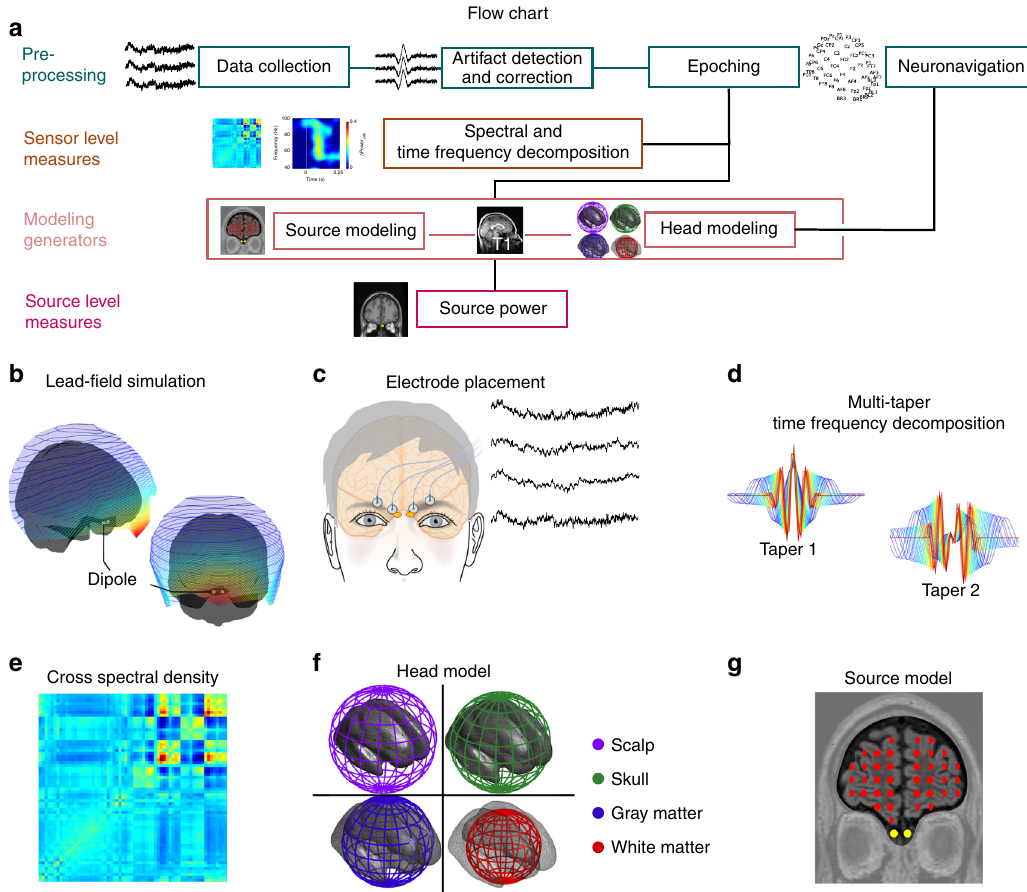
Fig. 1 Overview of the methodological procedure to extract signal from olfactory bulbs. a Flowchart of the procedures. b A lead- fi eld simulation of olfactory bulb activity projected on the scalp using a symmetrically located dipole in each olfactory bulb (left/right). c Electrode placement for the electrobulbogram (EBG) on the forehead and exemplary recordings. d Multi-taper time-frequency decomposition using two Slepian tapers. e Cross- spectral density between scalp electrodes and EBG channels. f Four concentric spheres used to construct the head model. g The undetermined source model of every voxel of brain with gray matter probability more than 40%, together with the digitalized sensor position of each individual and head model, were fed into dynamical imaging of coherent source to localize the cortical